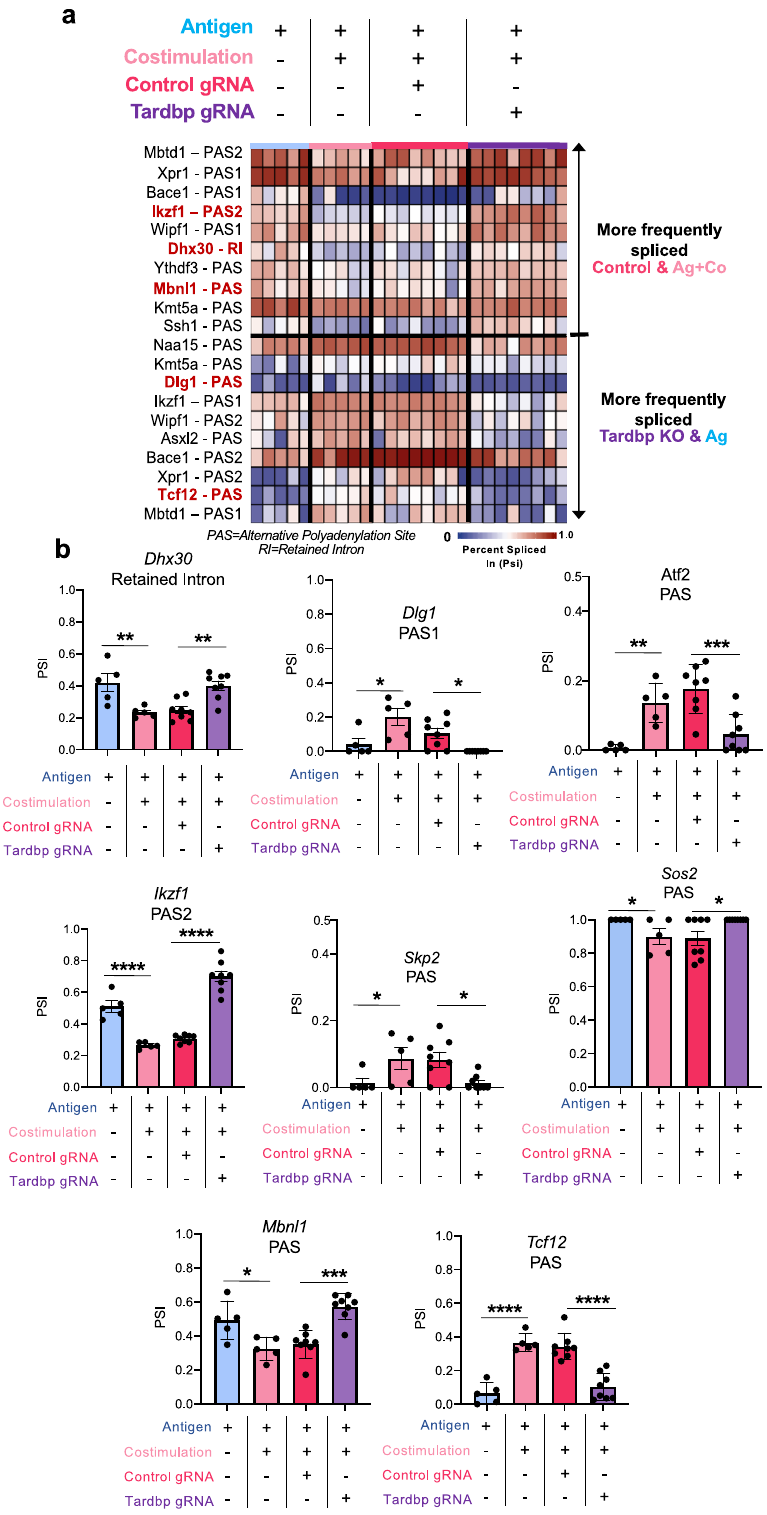
Fig. 5 Tardbp regulates costimulation-speci fi c alternative splicing and polyadenylation events in CD8 + T cells. a Deep RNA-seq analyzed with Whippet of Ag, Ag + Co, Control, and Tardbp KO CD8 + T cells after 4 days in vivo. Filtering included probability>0.9, Percent-spliced in (Psi) difference>0.1 or < − 0.1; total reads>50; top 20 splicing events of 41 shown by Psi difference, n = 5/group for Ag and Ag + Co, n = 8/group for Ctrl and Tardbp gRNA. b Examples of speci fi c RNA alterations from ( a ) and Supplementary Data 5 (highlighted), n = 5/group for Ag and Ag + Co, n = 8/group for Ctrl and Tardbp gRNA. PAS = Alternative Polyadenylation Site. RI = Retained Intron. PAS1 or PAS2 indicate the presence of multiple PAS sites in one gene, with PAS1 being the upstream location and PAS2 the downstream. Selection criteria for Fig. 5 is shown in Supplementary Fig. 6. Data are presented as mean values + / − SD using a two-sided t test with Benjamini, Krieger and Yekutieli to control FDR where * represents n digits after decimal for p value. Source data are provided as a Source Data fi le.